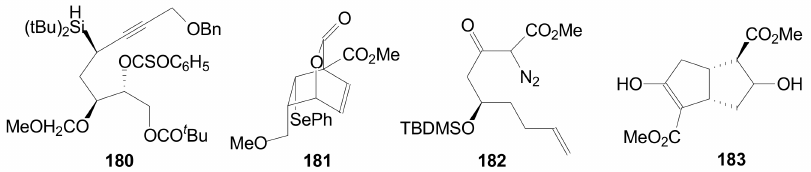
Figure 7. Raw materials for other synthesis of Corey